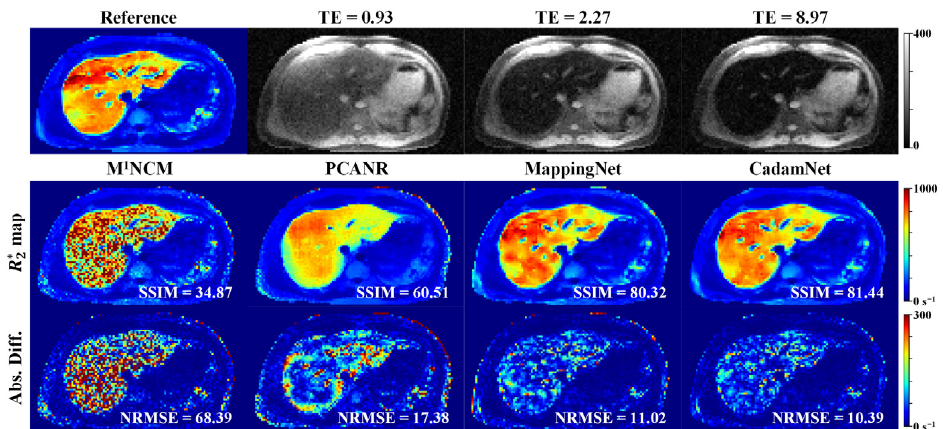
Figure 4. R2* maps for the simulated testing dataset with Rician noise ( σ g = 9). Top: Reference of R2* map and simulated noisy T2*-weighted images at three different echo times (ms). Bottom: R2* maps reconstructed using M 1 NCM, PCANR, MappingNet, and the proposed CadamNet methods, and the absolute difference maps are shown below the corresponding R2* maps. The SSIM of each R2* map is shown in its bottom right corner, and the NRMSE is shown in the absolute difference map.